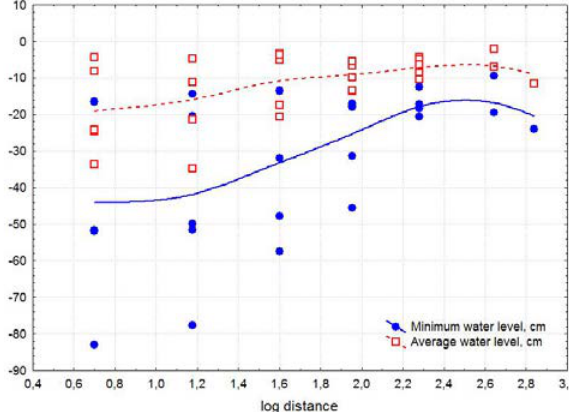
Figure 6. Relationships between the representation of bog-specific and fen-specific species, and minimum water level.